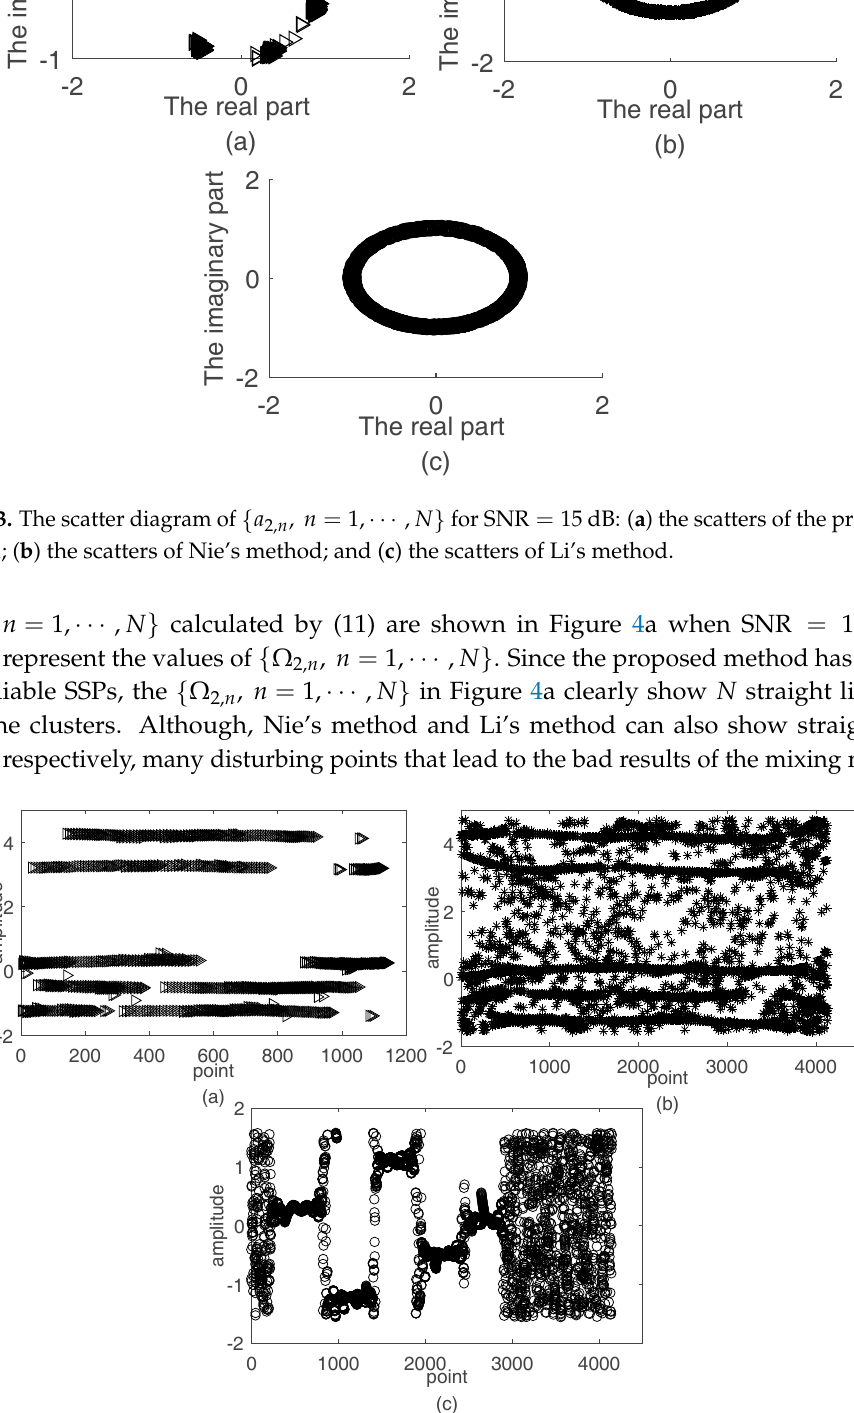
Figure 4. The amplitude of      , 1, , n N for  SNR 15 dB : ( a ) the performance of the Figure 4. The amplitude of { Ω 2, n , n = 1, · · · , N } for SNR = 15 dB: ( a ) the performance of the proposed 2, n method; ( b ) the performance of Nie’s method; and ( c ) the performance of Li’s proposed method; ( b ) the performance of Nie’s method; and ( c ) the performance of Li’s method.